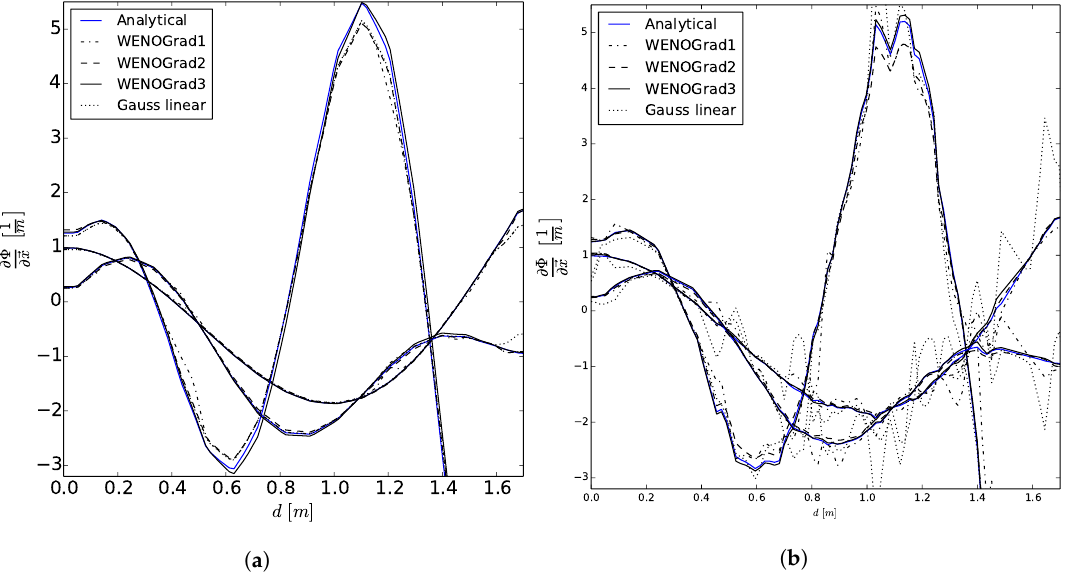
Figure 10. Results of the gradient calculation in the principal directions along the diagonal d . ( a ) 5800 hexahedra; ( b ) 6048